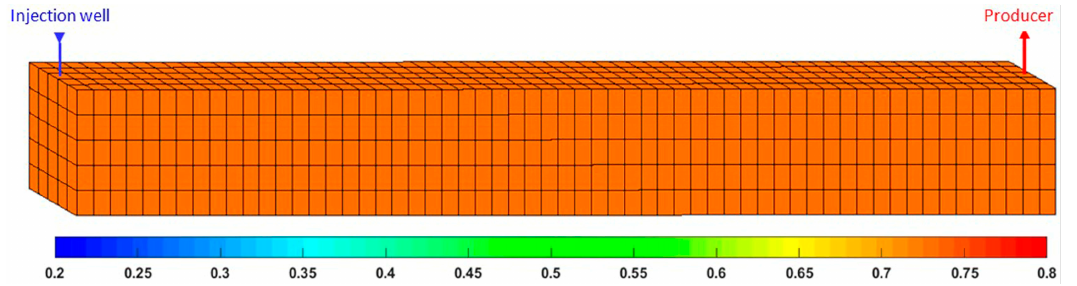
Figure 14. Well location and 3D distributions of heavy oil saturation in the initial state.